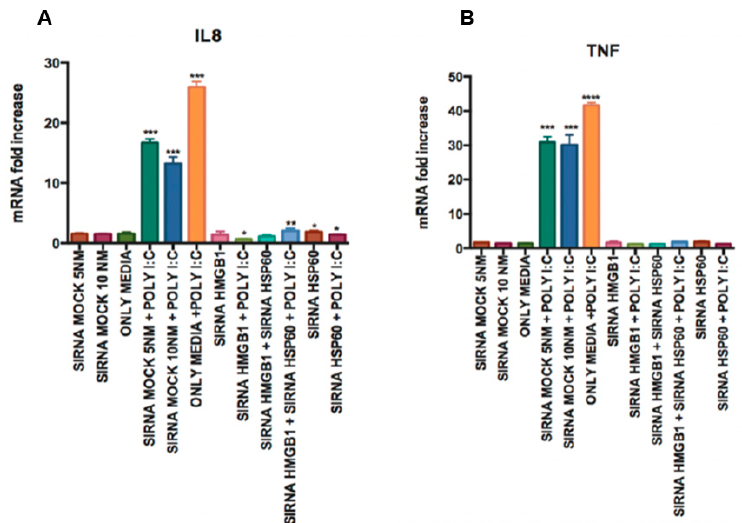
Figure 8. Silencing of HMGB1 and Hsp60 leads to the downregulation of pro-inflammatory cytokines: IL8 ( A ) and TNF ( B ) were downregulated upon poly I:C stimulation, and the silencing of HMGB1 and Hsp60 in epithelial cells. Statistical test: one-way ANOVA followed by Tukey’s multiple comparison test (* p < 0.05, ** p < 0.01, *** p < 0.001, **** p < 0.0001) and the results are represented as the mean ± SE ( n = 3) from three independent experiments.